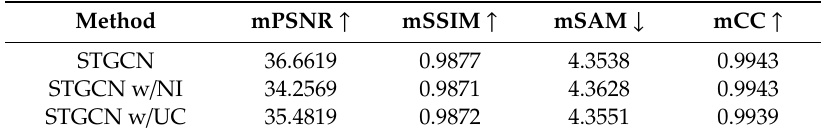
Table 5. Quantitative evaluation of cloud removal algorithms with di ff erent up-sampling methods on data I. w / NI is short for with the nearest interpolation. UC is short for